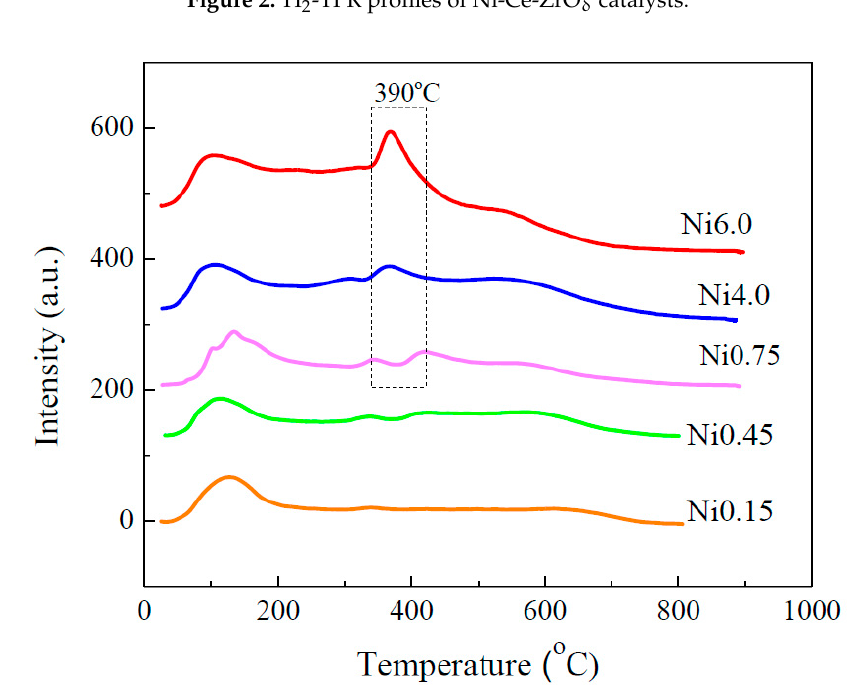
Figure 3. CO 2 -TPD profiles of Ni-Ce-ZrO δ catalysts.